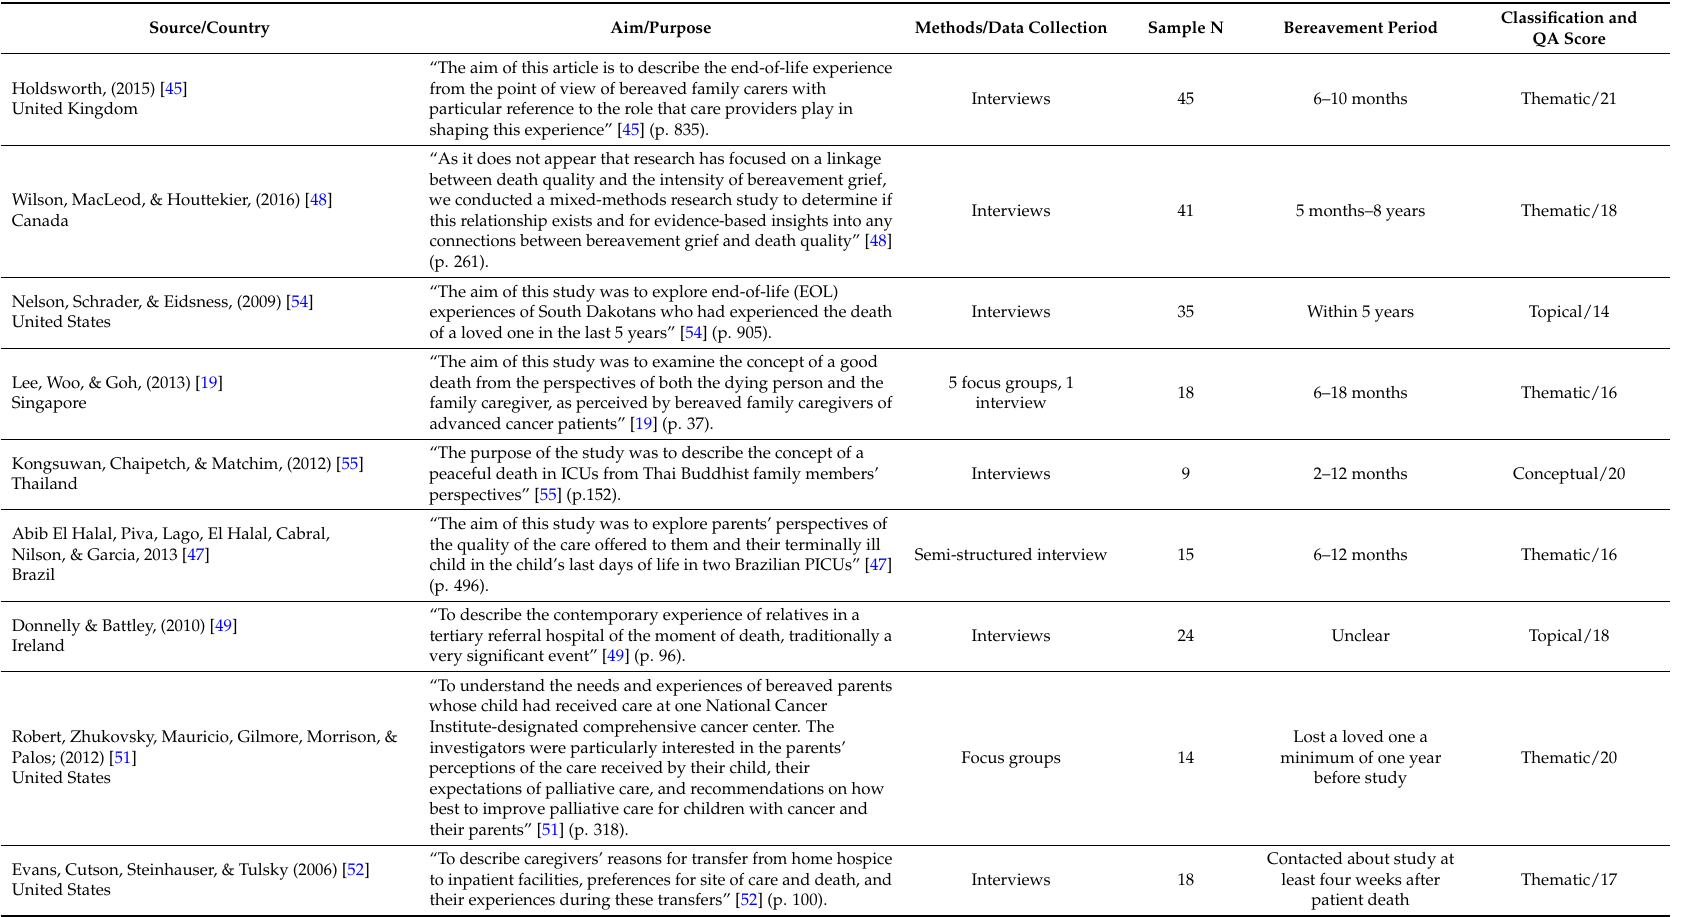
Table A1. Step 3 Classification of